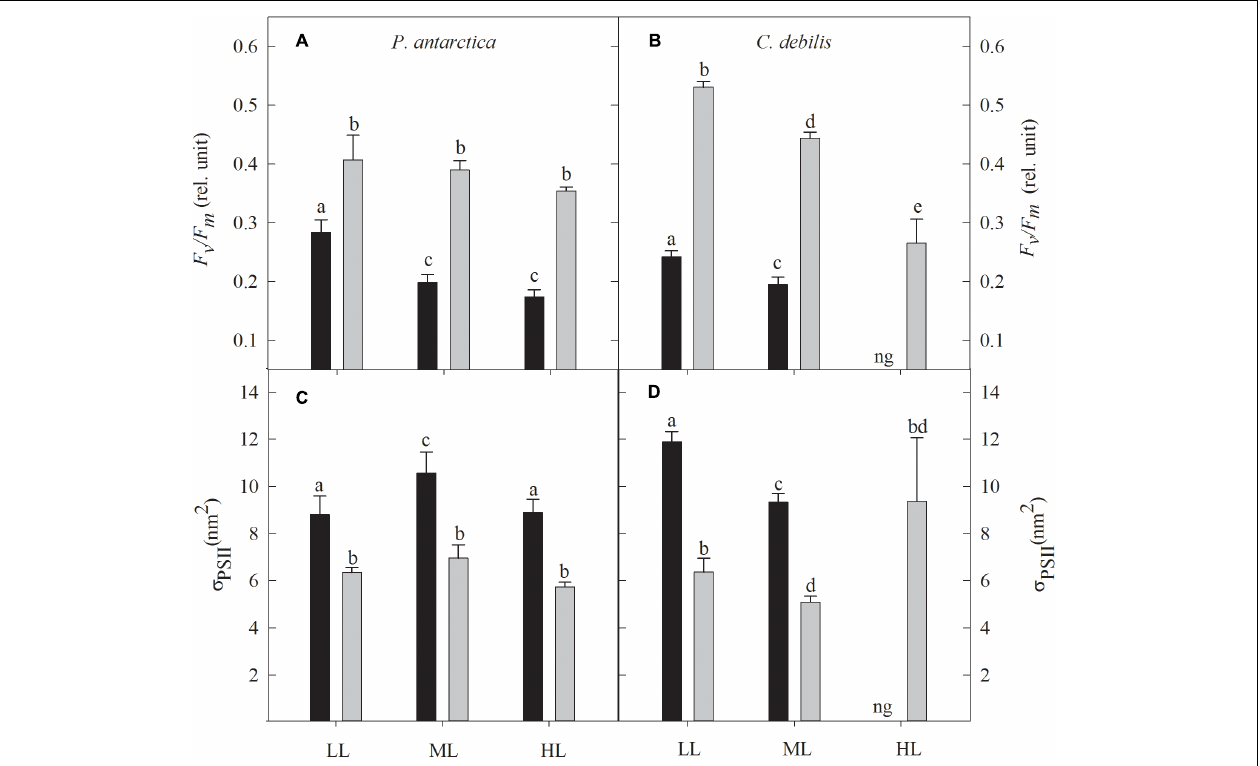
FIGURE 1 | The dark-adapted maximum PSII quantum yield F v /F m (A,B) and the dark-adapted functional absorption cross section of PSII photochemistry σ PSII (C,D) for P. antarctica (A,C) and C. debilis (B,D) acclimated to control (black bars) or Fe-enriched (gray bars) conditions combined with low (LL), medium (ML) or high light (HL). C. debilis did not grow in control HL treatments as indicated by ng. Values represent the means ± SD ( n = 3). Different letters indicate significant differences between treatments ( p <